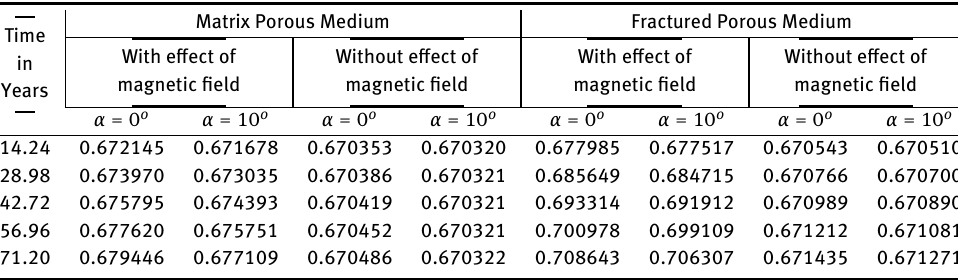
Table 4: Numerical values of saturation rate in volcanic sand in an inclined fractured and matrix porous medium with the effect of magnetic field